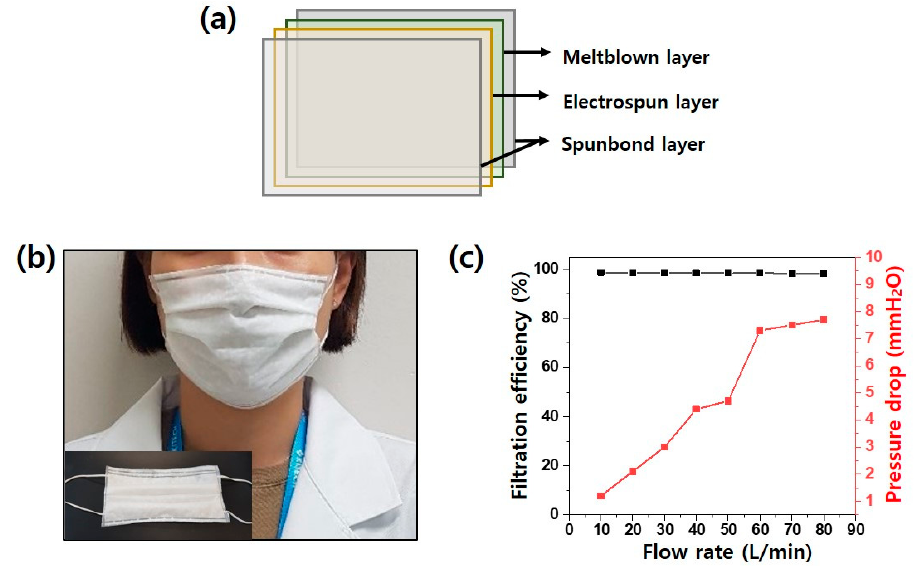
Figure 6. Schematic diagram of the structure of the filter media ( a ). A photograph of a person wearing the fabricated mask ( b ). Filtration performance evaluation by flow rate ( c